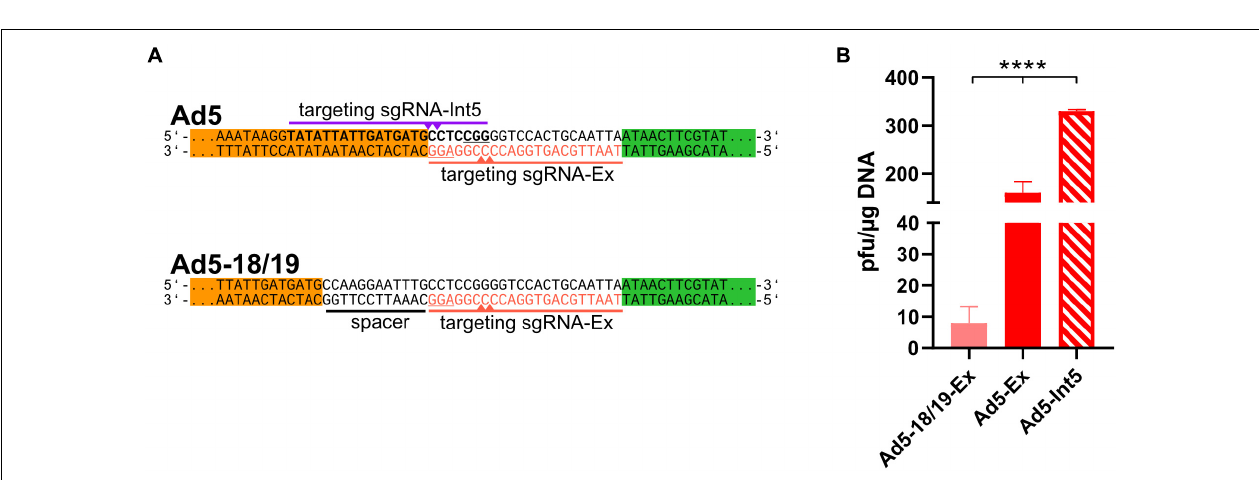
FIGURE 1 | CRISPR-Cas-mediated cleavage in cells yielded efficient rescue of recombinant adenoviruses based on HAdV-5. (A) The ITRs on an existing rAd-plasmid were extended by artificial CRISPR/Cas9 target sequences ( ACT sequences , red), which were targeted by sgRNA-Ex (red line, PAM is underlined) inducing double-strand breaks 6–7 bp outside of the ITRs (indicated by the red triangles on the sgRNA targeting strand only). (B) Reconstitution efficiency of rAds in 293A cells after transfection of circular pBWH-C5-mChe (an ACT-flanked Ad5-bacmid) alone (cir5), a linearized rAd5 bacmid (lin5), a circular rAd5 bacmid carrying fusion ITRs (ITRf 5) or co-transfection of circular pBWH-C5-mChe with pAR-gRNA-Cas9F-Amp, a Cas9, and gRNA-Ex expressing helper plasmid for CRISPR/Cas-mediated terminal resolution (CTR 5). The appearing plaques were counted after seeding the transfectants into multiwell plates by observing the plates for 14 days after transfection. Statistical significance was determined using Welch ANOVA tests. (C) The rAd reconstitution efficiencies (as foci/ µ g DNA) in 293A cells of pBWH-C5-mChe-DD-Cas9, expressing conditional Cas9 (green bars) with co-expression of sgRNA-Ex, in the presence of stabilizer Shield-1 at the indicated concentrations are compared to the efficiency of CTR using Cas9F as for CTR 5 in (B) (red bar). The primary rescue efficiencies were obtained as in (B) . Significance was calculated using ordinary one-way ANOVA. * p < 0.05 and ** p < 0.01.